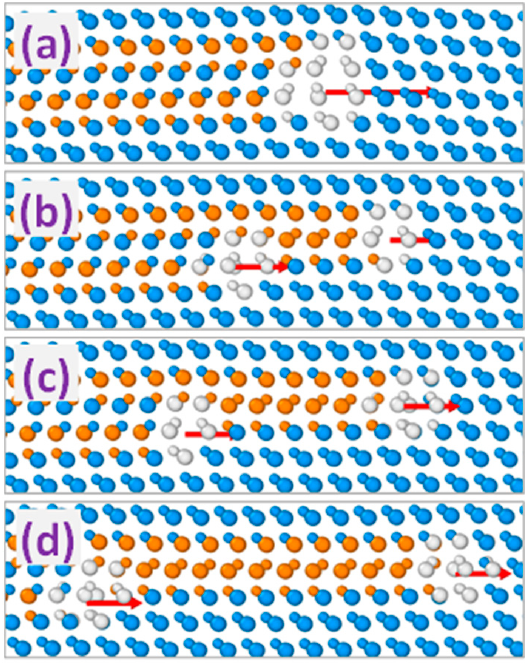
Figure 2. MD simulated evolution of the dislocation complex formed by a pair of 90 ° Shockley partial dislocations with equally oriented Burgers vectors. Simulated time: ( a ): 0, ( b ): 10, ( c ): 20, and ( d ): 50 ps, respectively. Arrows indicate the directions of the Burgers vectors of complex (a) and single dislocations ( b – d ).